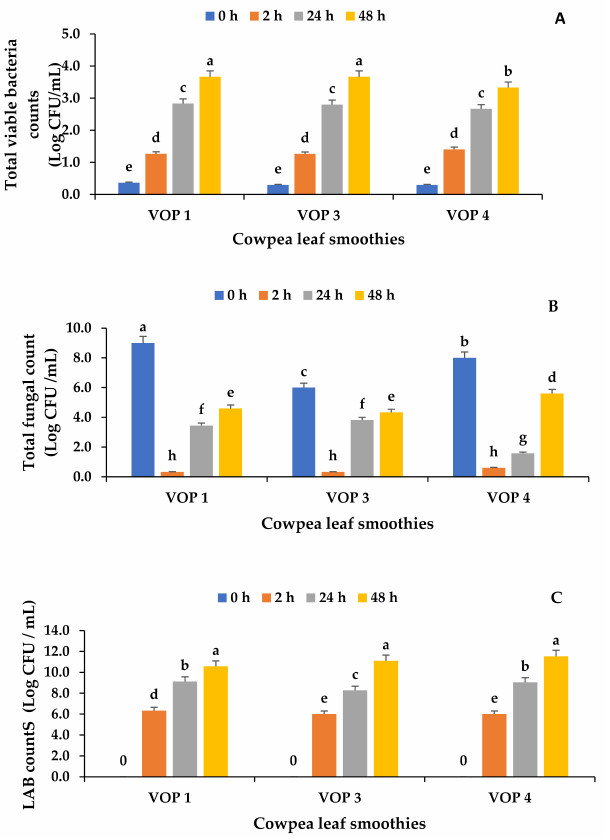
Figure 1. The microbial load in fermented and unfermented cowpea leaf smoothies. ( A ) Total viable bacterial count, ( B ) total fungal count, and ( C ) lactic acid bacteria count. The data presented on the graphs consist of average quantities ± SD of three independent samples. Different letters on the bars represent statistically significant differences ( p < 0.05). VOP 1, VOP 3, and VOP 4 are different cowpea leaf cultivar smoothies, and units are shown as colony-forming units per millilitre (CFU/mL).